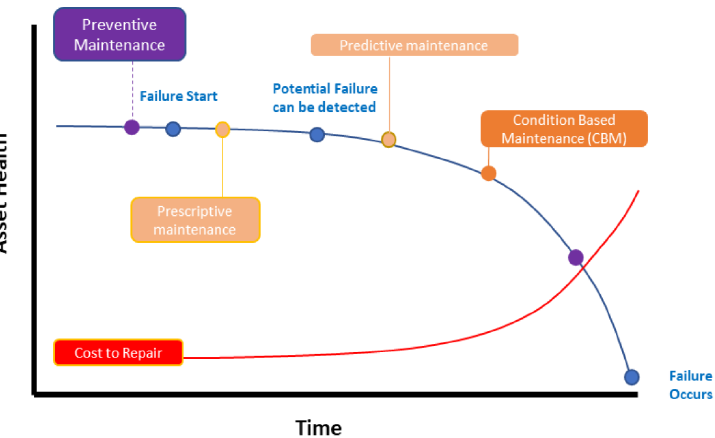
Figure 4. Maintenance overview: an example of the corrective, preventive, predictive and CBM approaches, SS-EN 13306 (2001) [47].